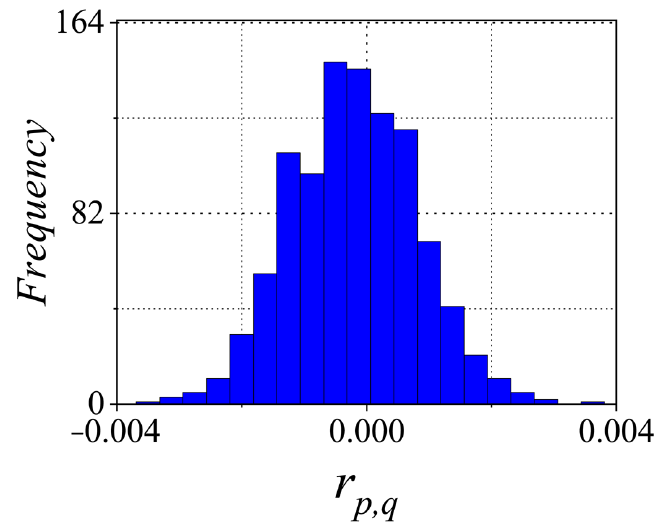
Figure 11. Statistical distribution for the different correlation